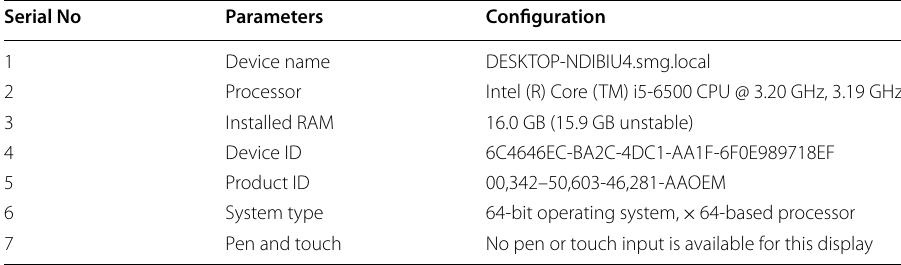
Table 2 System configuration of the designed